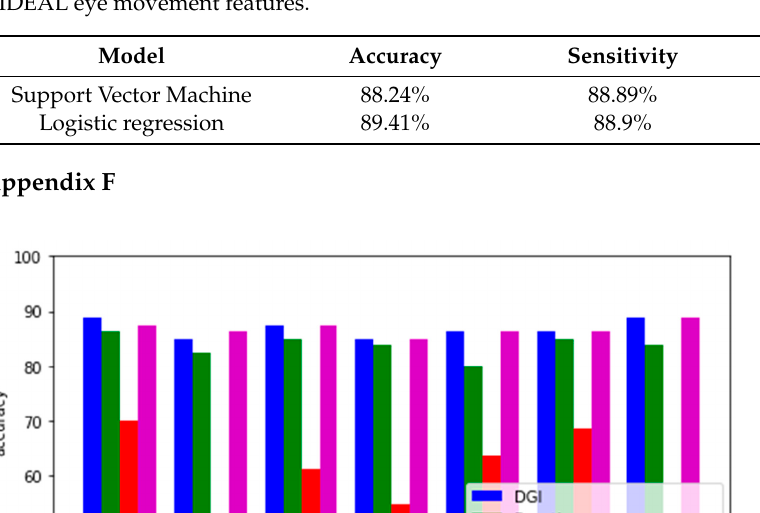
Table A4. Logistic regression scores for the two grouped paintings dataset using AIDEAL eye movement features.